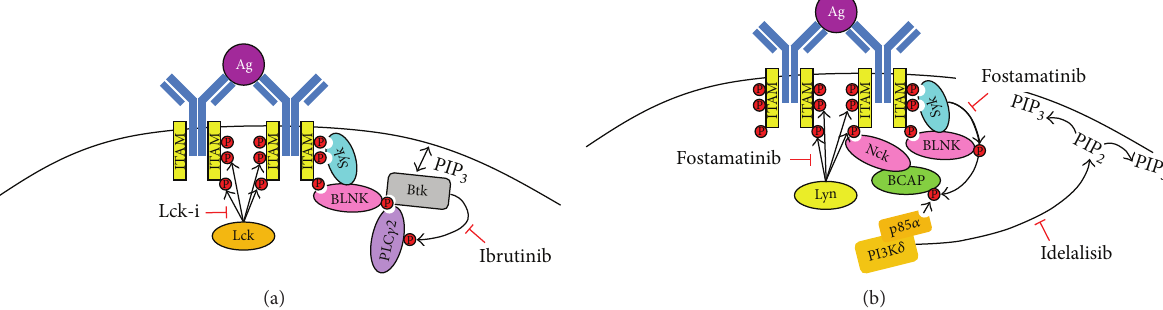
Figure 4: Points of inhibition for ibrutinib, idelalisib, fostamatinib, and Lck-i in the BCR signaling pathway. Illustration of proximal signals initiated during BCR engagement and points where well described inhibitors act. (a) Lck-i acts to inhibit the most proximal signaling event of SFK-mediated phosphorylation of tyrosine residues within CD79. Ibrutinib acts to inhibit the ability of Btk to phosphorylate and activate PLC 𝛾 2. (b) Fostamatinib acts to inhibit Syk kinase activity as well as that of Lyn. Idelalisib works to inhibit PI3K 𝛿 to limit the formation of PIP 3 and has the effect of blocking membrane interaction of signaling proteins containing PH domains such as PDK1, Akt, and